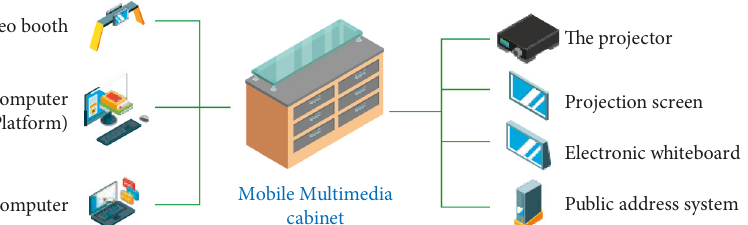
Figure 1: English assisted teaching process.